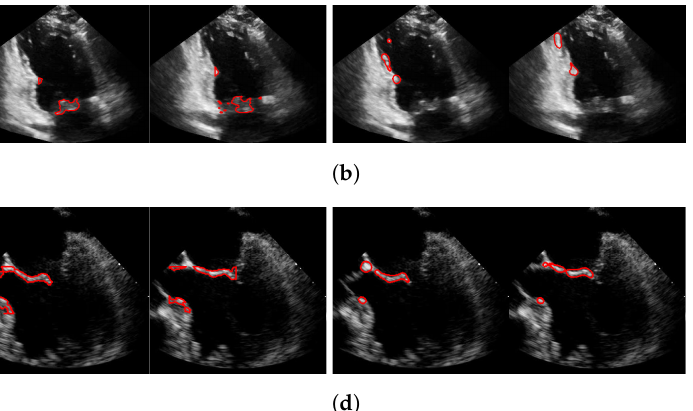
Figure 16. Segmentation in the cases of the largest differences between the f1-scores of our approach (segmentation with windowing) ( a , c ) and the one of Dukler et al. ( b , d ). The results in ( a , b ) belong to the blue rightmost bar of Figure 15, the results in ( c , d ) belong to the leftmost